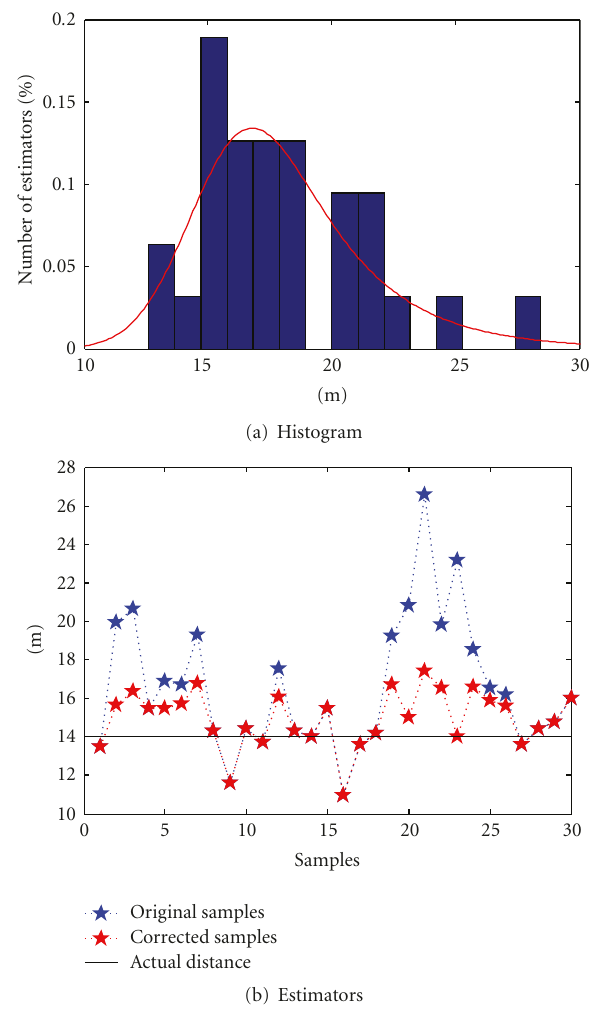
Figure 5: NLOS error correction from a record of distance estimates. (a) Histogram of distance estimates and the PDF that best fits the data. (b) Record of original and corrected distance estimates after having applied the PNMC